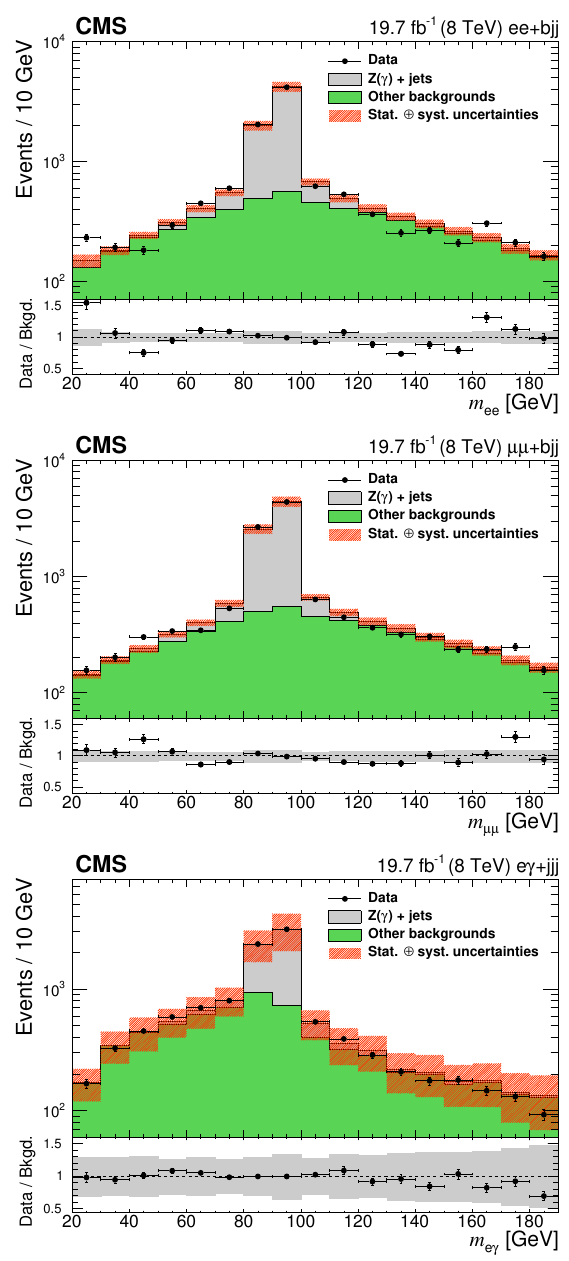
Figure 2 . The dilepton invariant masses used in determining SF and (middle pane) for the muon channels. The lower pane shows the result of the (cid:12)t of m e (cid:13) SR1 electron data (without the b tag requirement) to determine SF e ! (cid:13) . The mass spectra are shown post-(cid:12)t after the application of the derived scale factors. The ratio of data to the total background is included in the lower panel of each plot. Uncertainties include the quadratic sum of all statistical and systematic components.